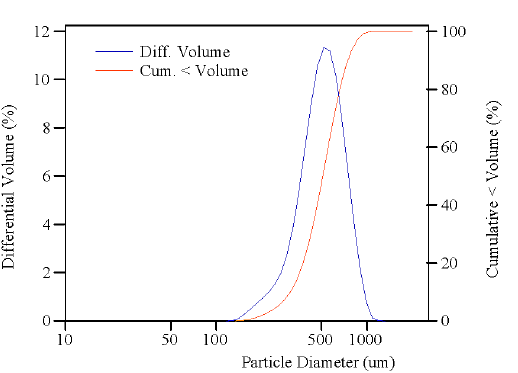
Figure 2. Result of grain size analysis.